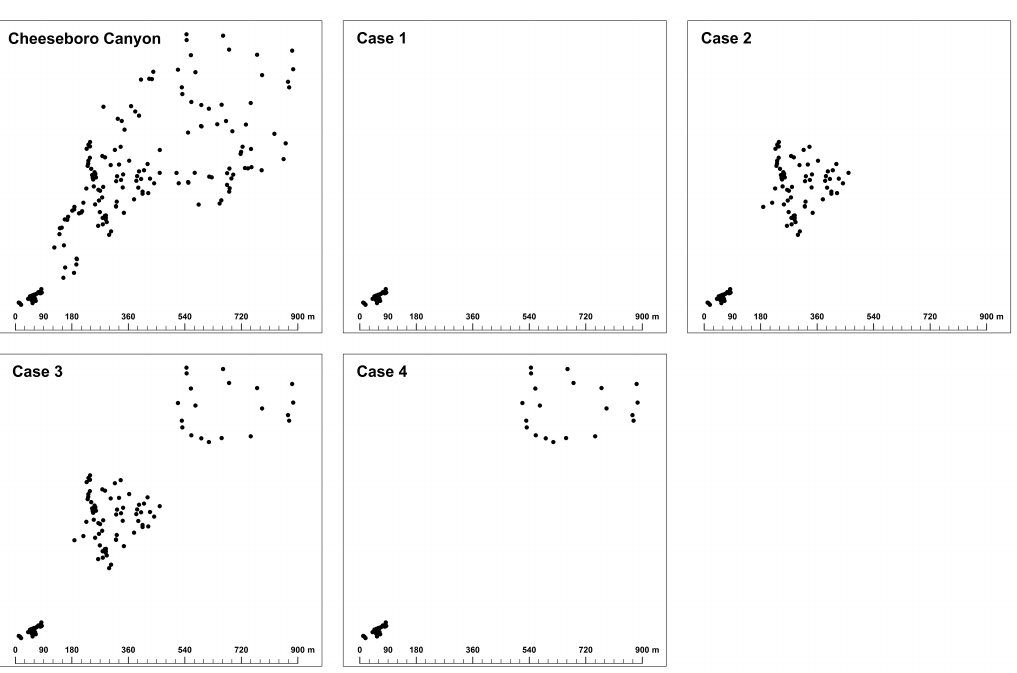
Figure 3. Decomposition of Cheeseboro population in four spatial arrangements to illustrate the effects of hypothetical point arrangements on clustering index. The observed pattern is shown in the upper left, Cases 1–4 isolate selected groups of stems from the observed pattern to emphasize how the index behaves with clusters of different sizes and intensity (local